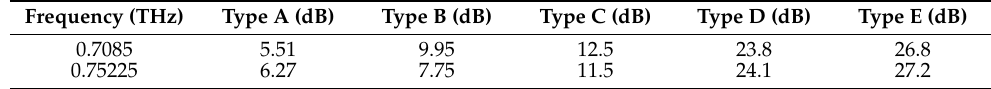
Table 6. Comparison of gains of various antenna